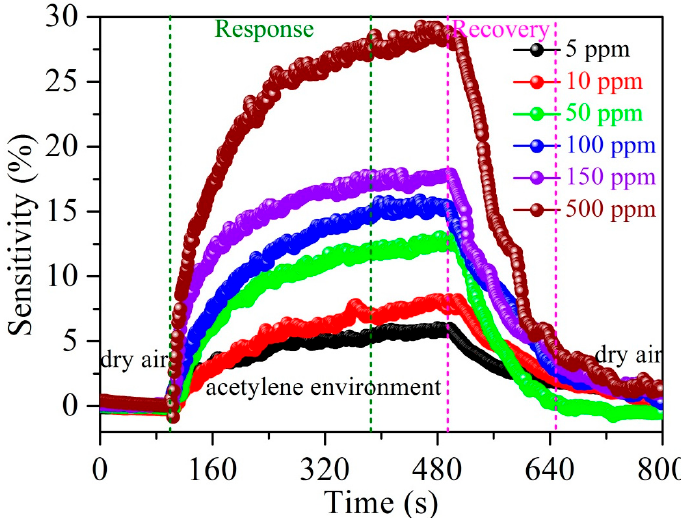
Figure 8. Typical response and recovery curves of the Ag–SnO 2 /rGO nanocomposite film sensor to acetylene pulses between 0 and 500 ppm.